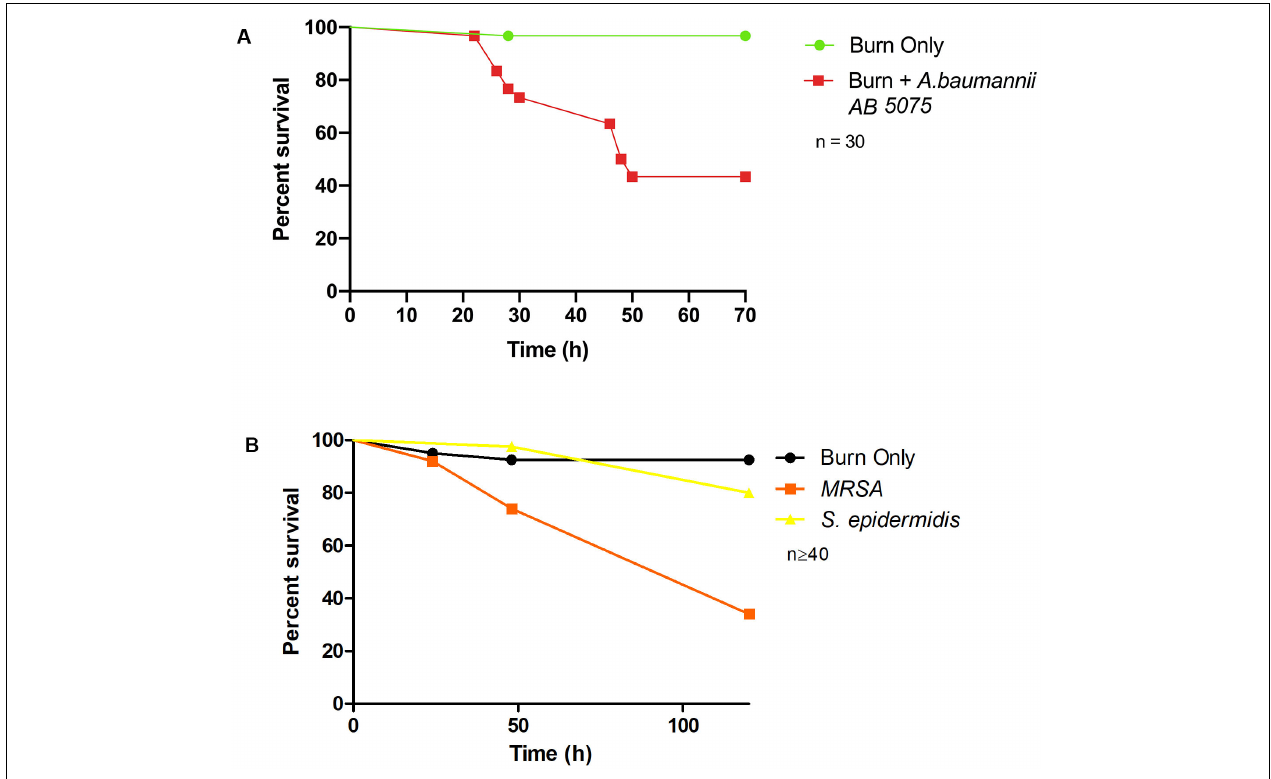
FIGURE 4 | Burn wound pathogenicity: (A) Percentage survival rate of larvae infected with A. baumannii AB5075 and the burn only control. A. baumannii AB5075 vs Burn Only Log Rank p < 0.001. (B) Percentage survival rate of larvae infected with MRSA and the non-burn wound pathogen S. epidermidis . MRSA vs Burn Only Log Rank p < 0.001, MRSA vs S. epidermidis Log Rank p < 0.001, S. epidermidis vs Burn Only Log Rank p < 0.14. n ≥ 30 per